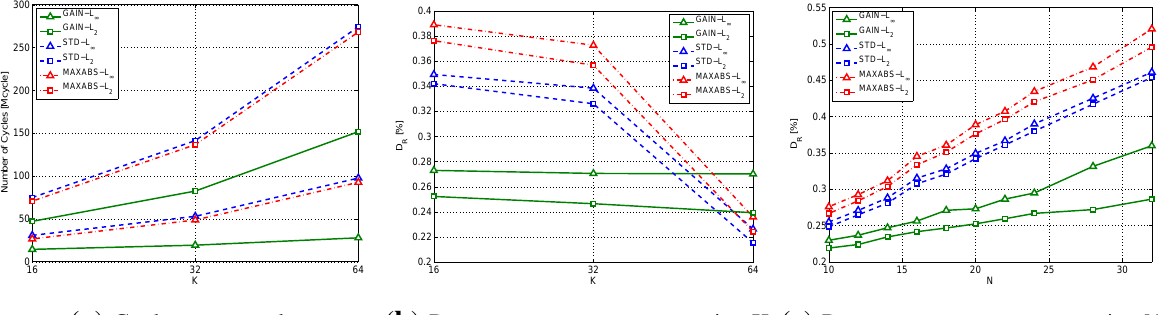
Figure 5. Analysis of the impact of the gain formula and of the norm used on the computational cost (( a ), with N = 20 and varying K ) and on the RMSE varying the number of motifs, K with N = 20 ( b ) or the motif length, N , with K = 16 ( c ). All graphs are plotted for b = 8